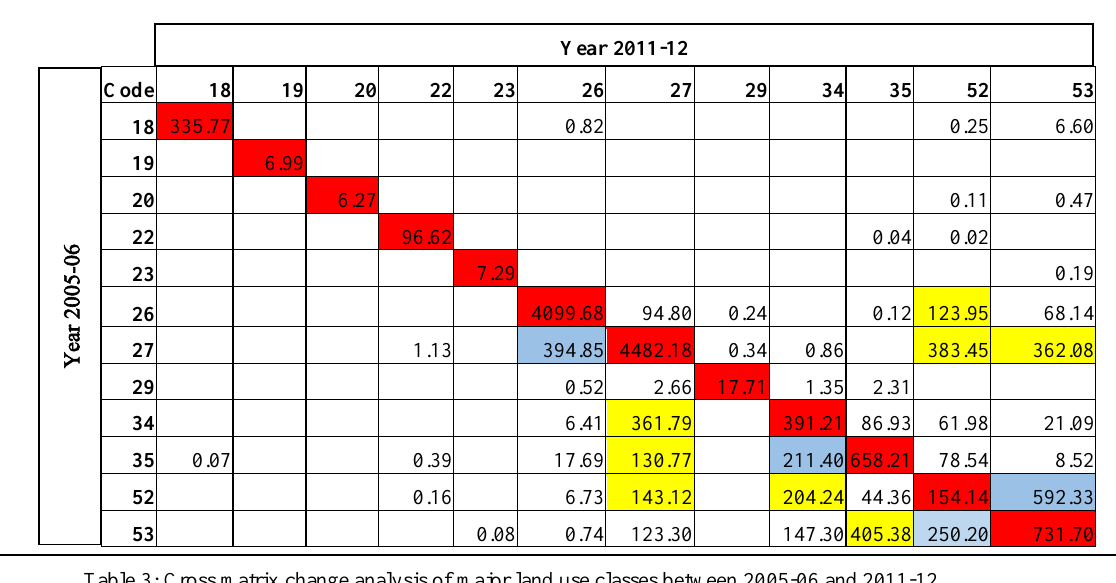
Table 3: Cross matrix change analysis of major land use classes between 2005-06 and